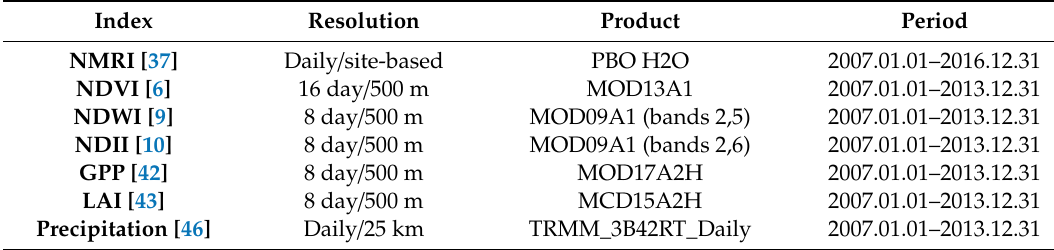
Table 1. Indices used in the